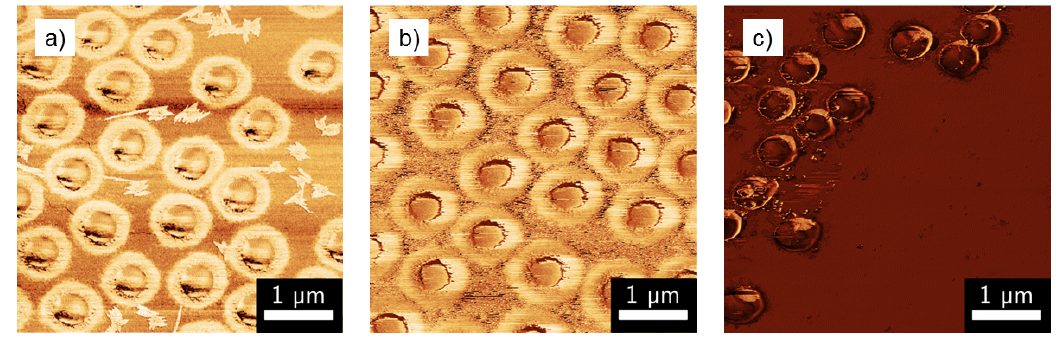
Figure 4. Phase images of ( a ) PNNPAM, ( b ) PNIPAM and ( c ) PNIPMAM homopolymer microgels obtained from AFM